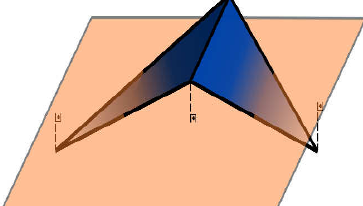
Figure 10: Overdone warpage of a quadrangle (blue) and its fitting plane (orange)